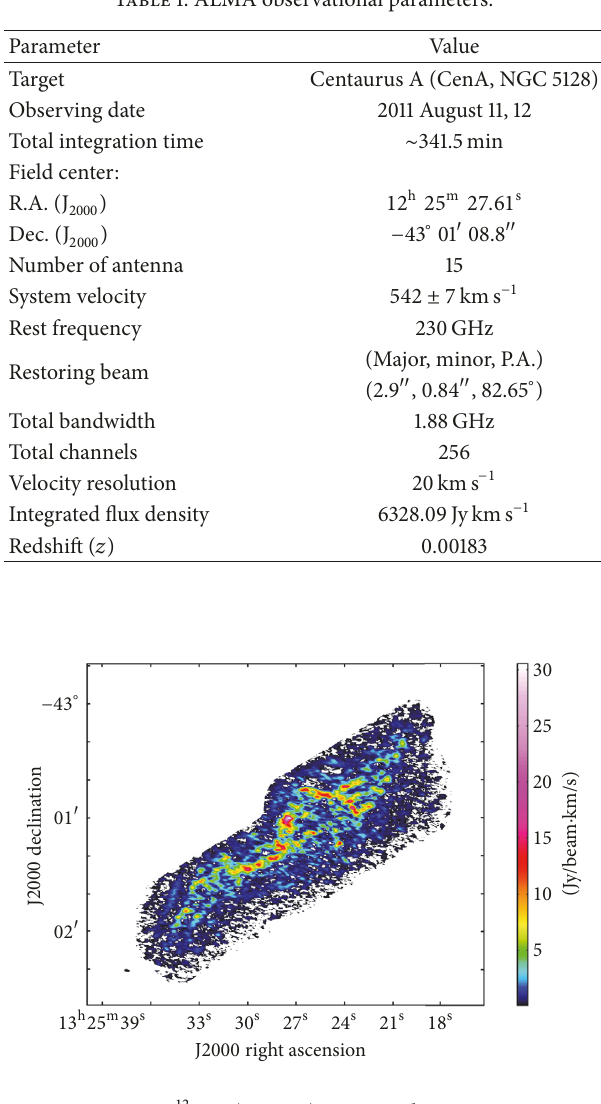
Figure 1: ALMA 12 CO ( 𝐽 = 2-1) integrated intensity images of Centaurus A (NGC